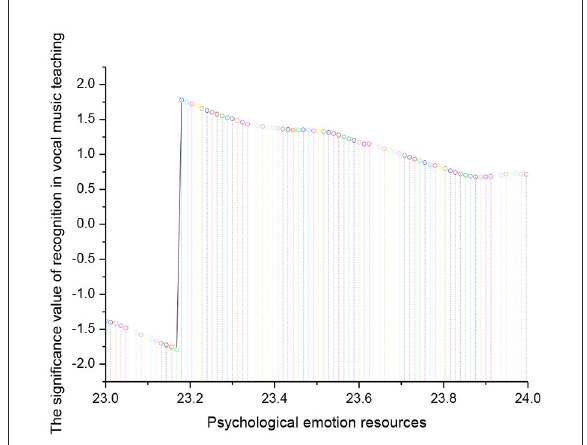
FIGURE4 The significance of psychological emotion recognition in vocal music teaching.